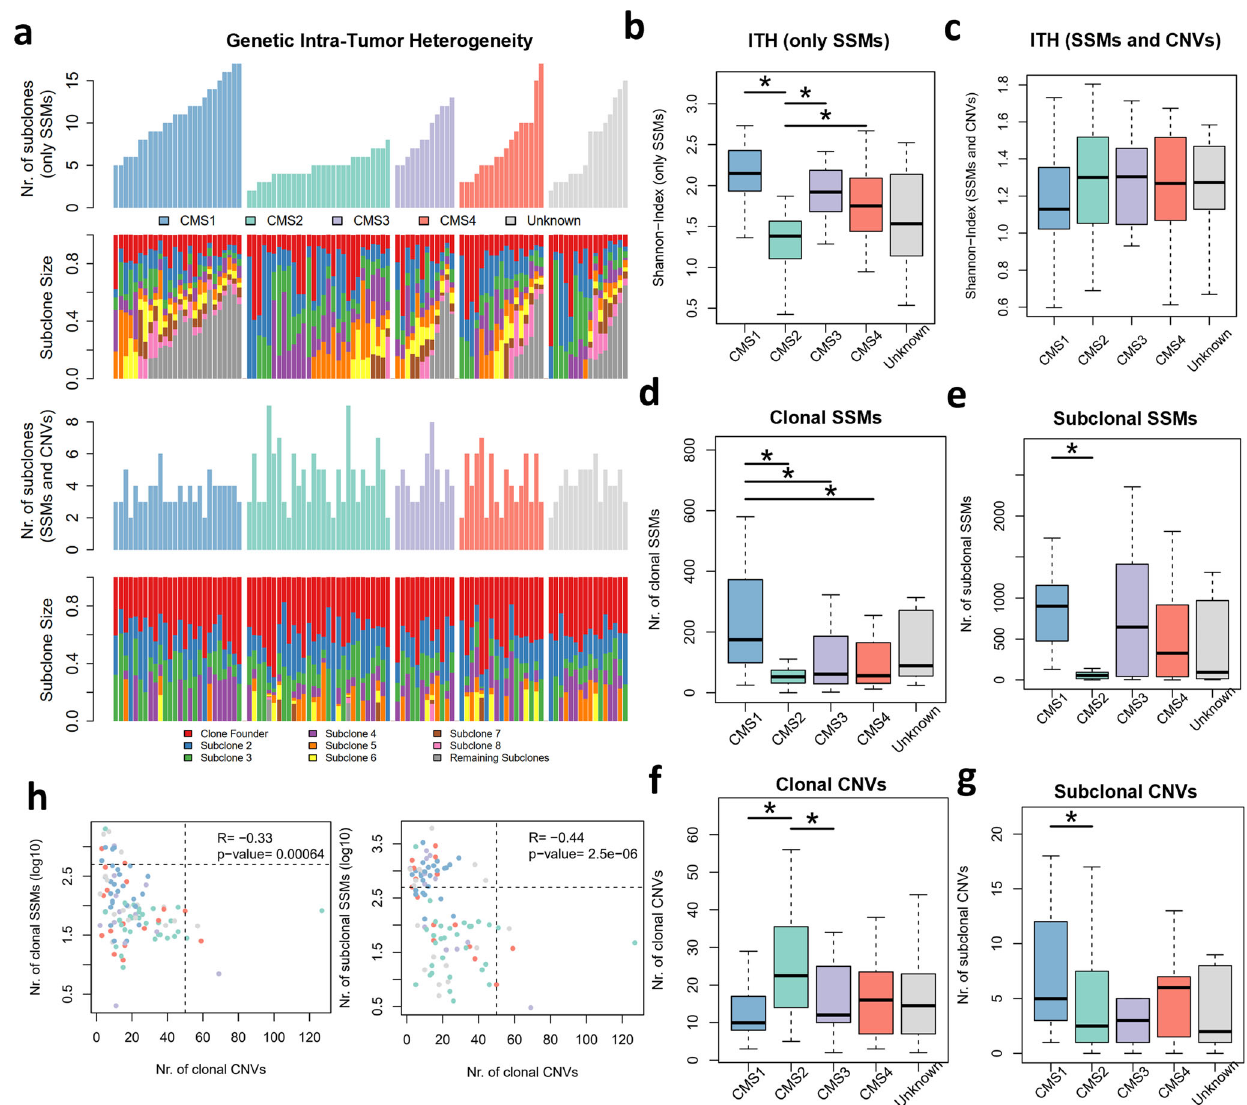
Fig. 1 Genetic Inter- and Intra-Tumor Heterogeneity of CRC. a Clonal composition of CRC samples grouped by CMS subtype, showing the number of subclones and respective relative frequency inferred with Expands (based on SSMs) or with PhyloWGS (using both SSMs and CNVs). b Distribution of the Shannon-Index values based on Expands clonal composition segregated by CMS subtype. c Distribution of the Shannon-Index values based on PhyloWGS clonal composition segregated by CMS subtype. d – g Distribution of the number of clonal SSMs ( d ), subconal SSMs ( e ), clonal CNVs ( f ), subclonal CNVs ( g ) for each CMS group. h Comparison between number of clonal/subclonal SSMs and clonal CNVs. Number of SSMs are represented in logarithm (log10). Estimate and statistical signi fi cance of the Pearson correlation are presented. Numbers of samples per CMS subtype: CMS1 n = 27; CMS2 n = 36; CMS3 n = 12; CMS4 n = 19; Unknown n = 18. *Wilcoxon signed-rank test p value <